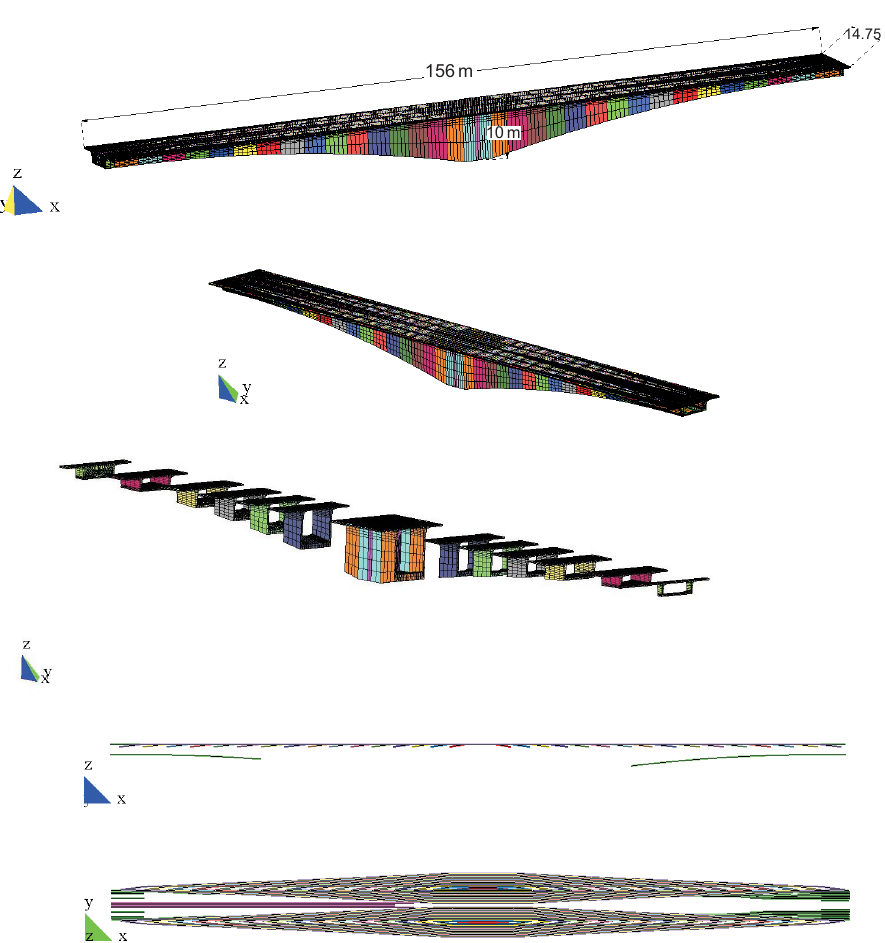
Figure 13. Three-dimensional finite element mesh model of the bridge, the mesh of its different segments, and the mesh of the steel